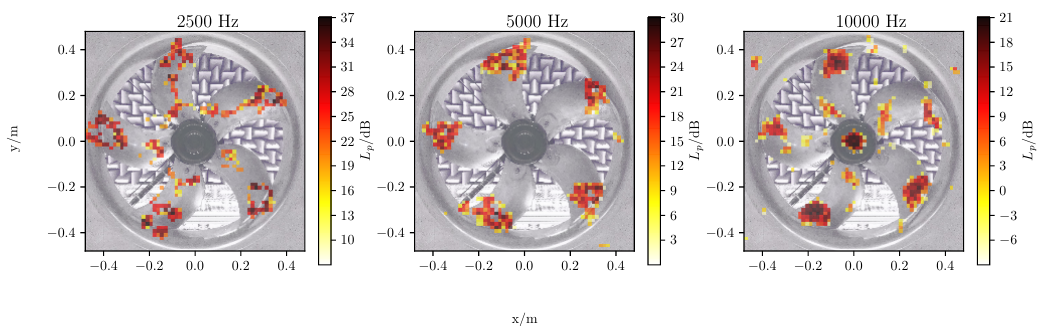
Figure 12. One-third octave band source maps for 2.5, 5 and 10 kHz obtained with the spiral array and cubic radial basis function interpolation between the microphones using DAMAS.